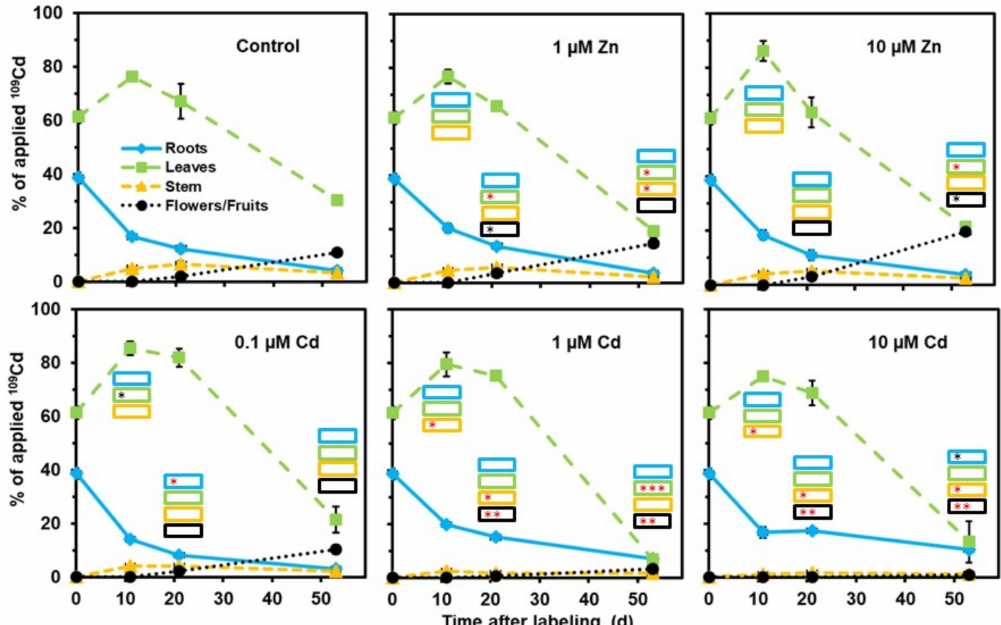
Figure 2. Influence of elevated cadmium (1 µ M Cd and 10 µ M Cd) or zinc (1 µ M Zn and 10 µ M Zn) concentrations in the nutrient medium on the redistribution of 109 Cd. The plants were labeled with 109 Cd in standard nutrient medium for 3 d before transferring them to the media indicated (day 0). Means + SE of four replicates are shown. Significantly higher (*, **, ***) and lower (*, **, ***) values than in control plants on the P = 0.05 (*, *), P = 0.01 (**, **), and P = 0.001 (***, ***) level are indicated in the insets for the various plant parts collected on day 11, day 21, and day 53 (Student’s t-test).